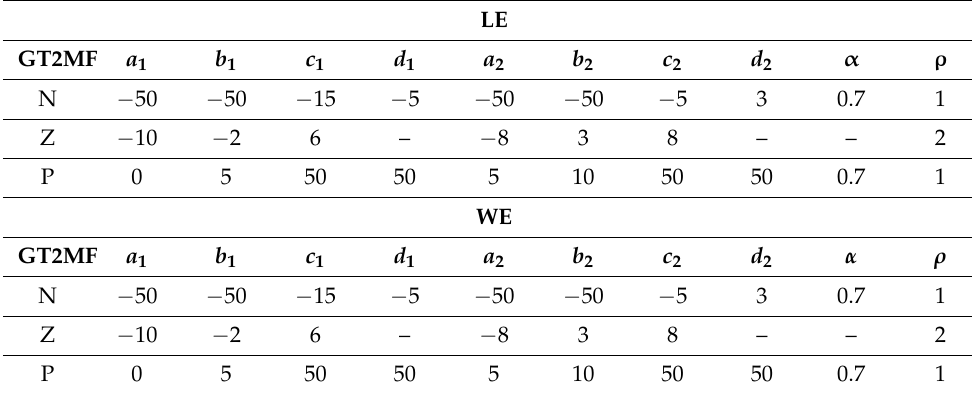
Table 2. GT2MF antecedent parameters.